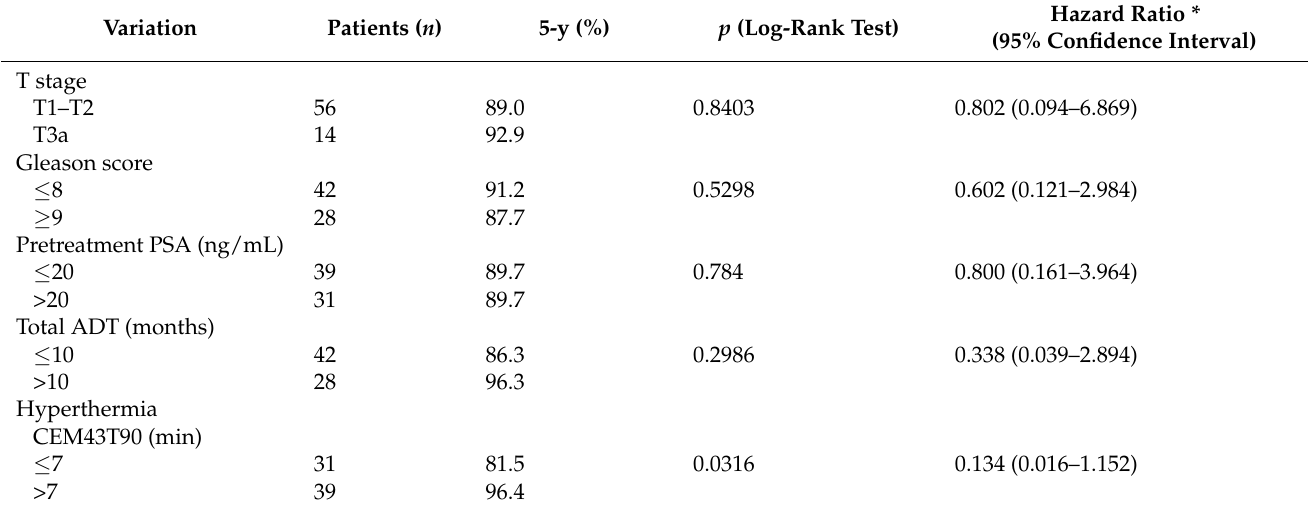
Table 3. Univariate analyses of certain factors for bDFS in 70 patients treated with IMRT plus regional hyperthermia.